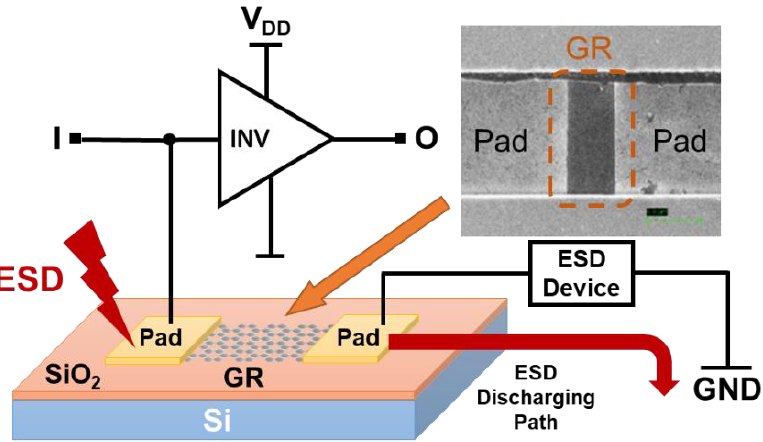
Figure 30. Concept for graphene GNR interconnects for on-chip ESD protection circuits. Inset: photo for a graphene nanoribbon wire fabricated.